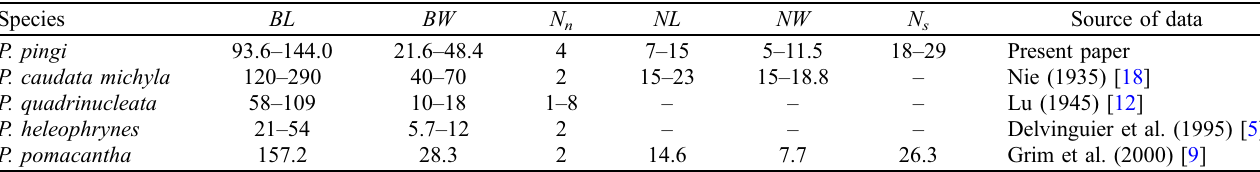
P. heleophrynes – Measurement in l m; BL = Body length, BW = Body width, N n = Number of nuclei, NL = Nucleus length, NW = Nucleus width, N s = Number of total somatic